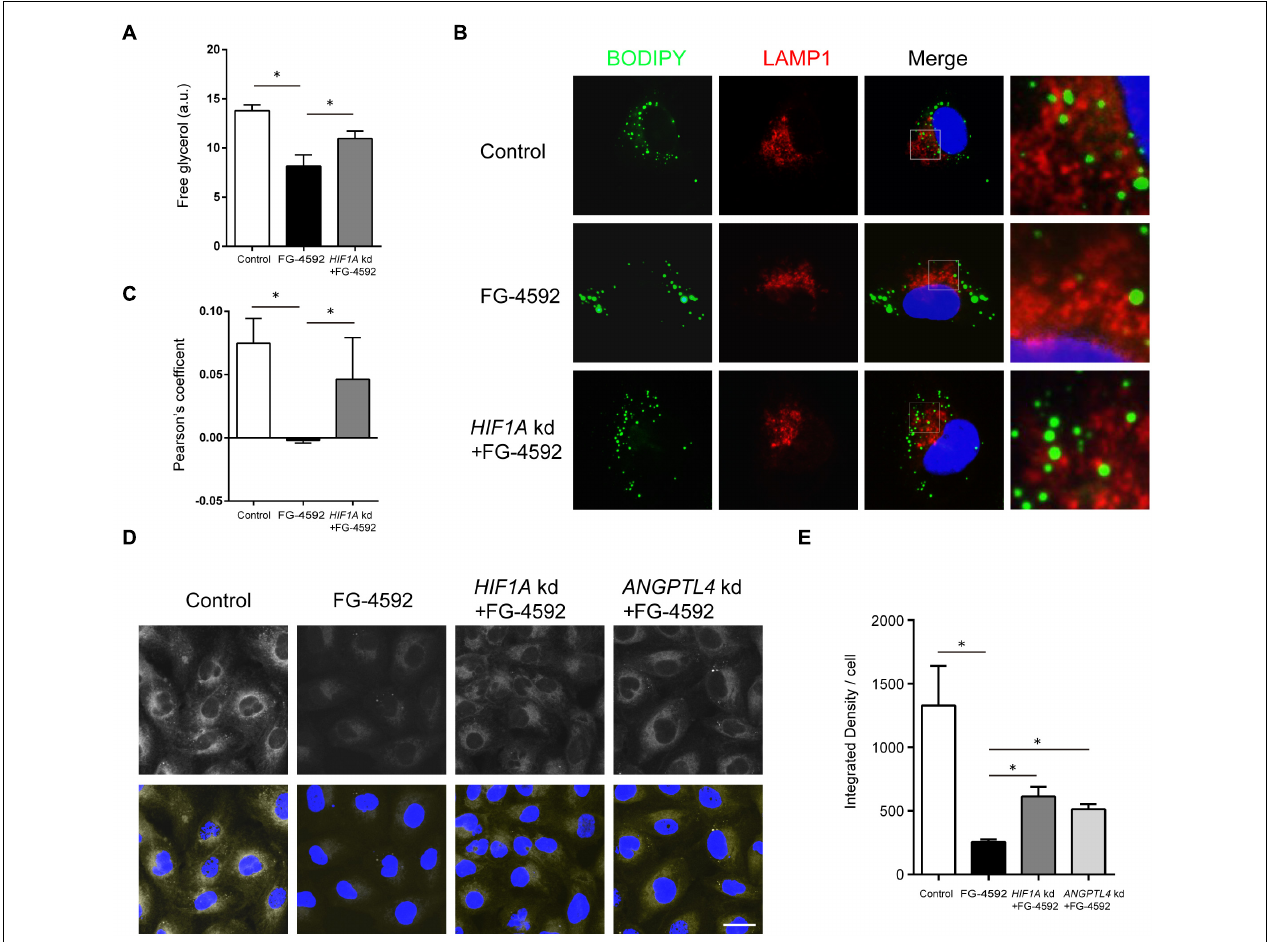
FIGURE 3 | HIF1 α decreased FA availability by inhibiting lipolysis and FA uptake. (A) Free glycerol released by HK2 cells after 24 h of culture in serum-limited medium in the presence or absence of 50 µ M FG-4592. Values were normalized to protein concentration. a.u, arbitrary units. (B,C) Colocalization of LDs and lysosomes was assessed by the Pearson’s coefficient. HK2 cells were cultured for 24 h with or without FG-4592 and then in serum-limited culture for 4 h. Lysosomes were marked by immunofluorescence staining of LAMP1 (red). LDs were labeled by BODIPY 493/503 staining. Blue: DAPI. (D,E) HK2 cells were cultured in the presence or absence of 50 µ M FG-4592 for 6 h and then treated with 2 µ M Red C 12 for 2 h. Red C 12 uptake was evaluated by confocal microscopy. Scale bar: 20 µ m. All images are representative of multiple experiments. HIF1A and ANGPTL4 kd: gene knockdown by siRNA. * p < 0.05. Values are expressed as the mean ±